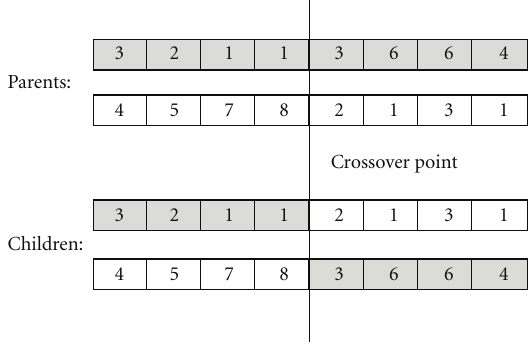
Figure 3: Single-point